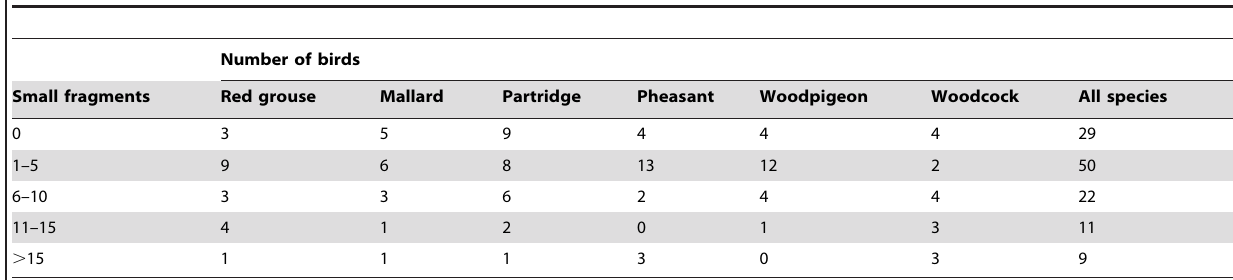
Table 2. Numbers of gamebirds recorded with various numbers of small radio-dense fragments detectable on X-rays.